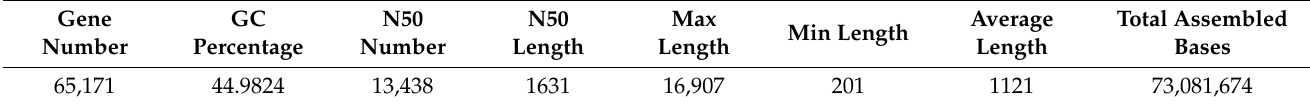
Table 1. Assembly quality statistics of RNA-seq of goldenrain